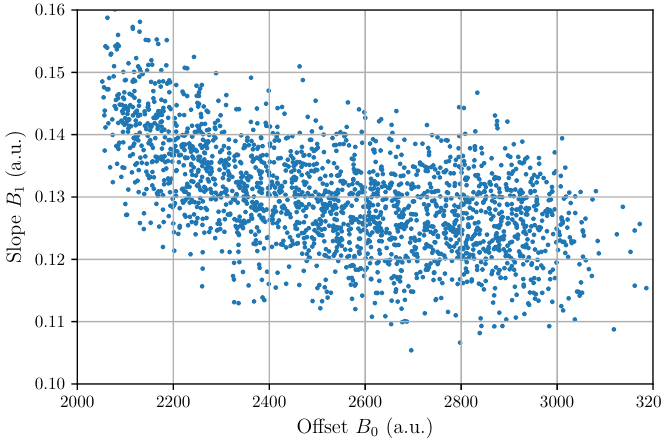
Figure 14. Scatter plot between offset and